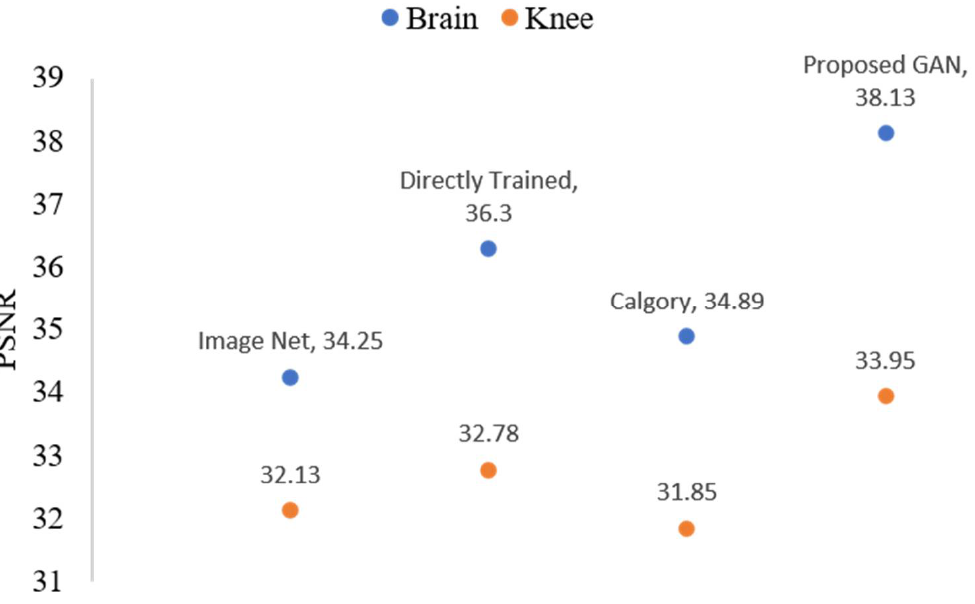
Figure 17. The blue dots represent brain data PSNR values, while orange dots represent knee data PSNR values of the reconstructed images when AF = 4 following TL.